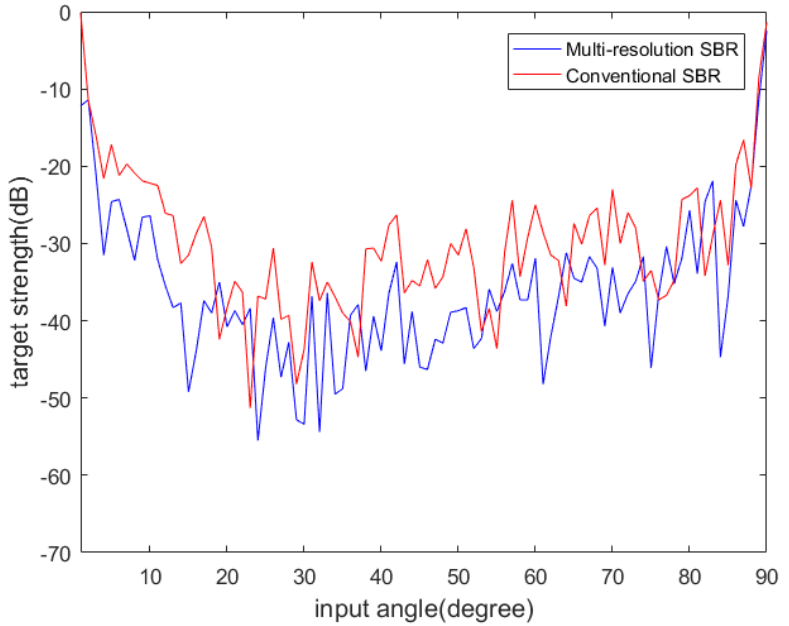
Figure 10. The comparison of the GPU-based multiresolution SBR result and the GPU-based conventional SBR result of the corner reflector.